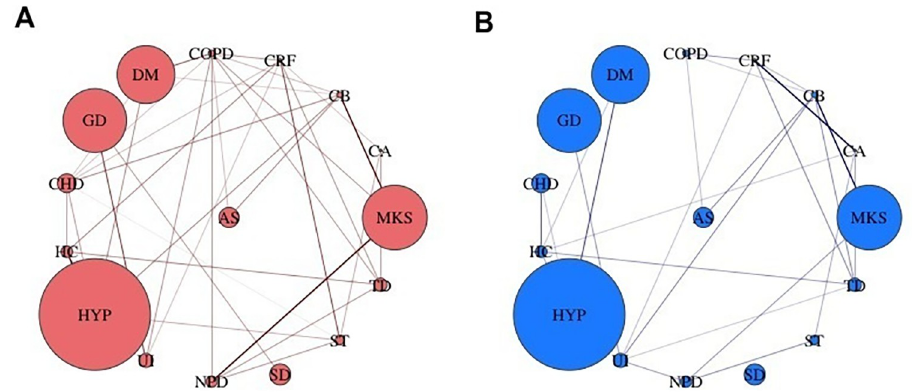
Fig 3. Multimorbidity networks for (A) women and (B) men aged 45 years and above, considering inclusion criterion for sixteen non-communicable diseases, Longitudinal Ageing Study in India (LASI), 2017–18.